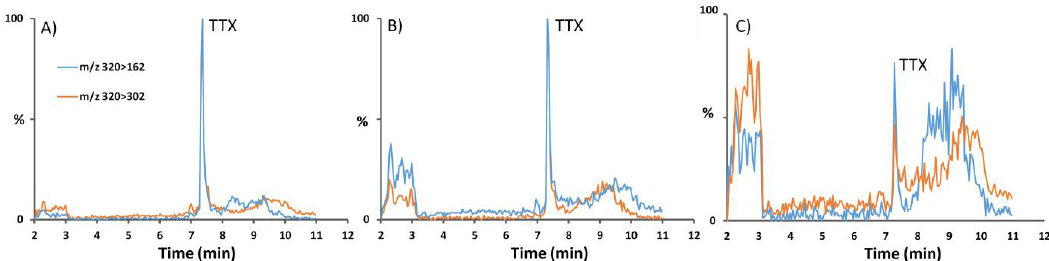
Figure 2. Multiple reaction monitoring (MRM) chromatograms of tetrodotoxin (TTX) obtained by HILIC-MS / MS analysis in ( A ) matrix match TTX standard of 40 µ g kg − 1 , ( B ) TTX spiked mussel extract of 25 µ g kg − 1 , and ( C ) TTX trace levels in mussels from Tavira (South Portuguese coast).